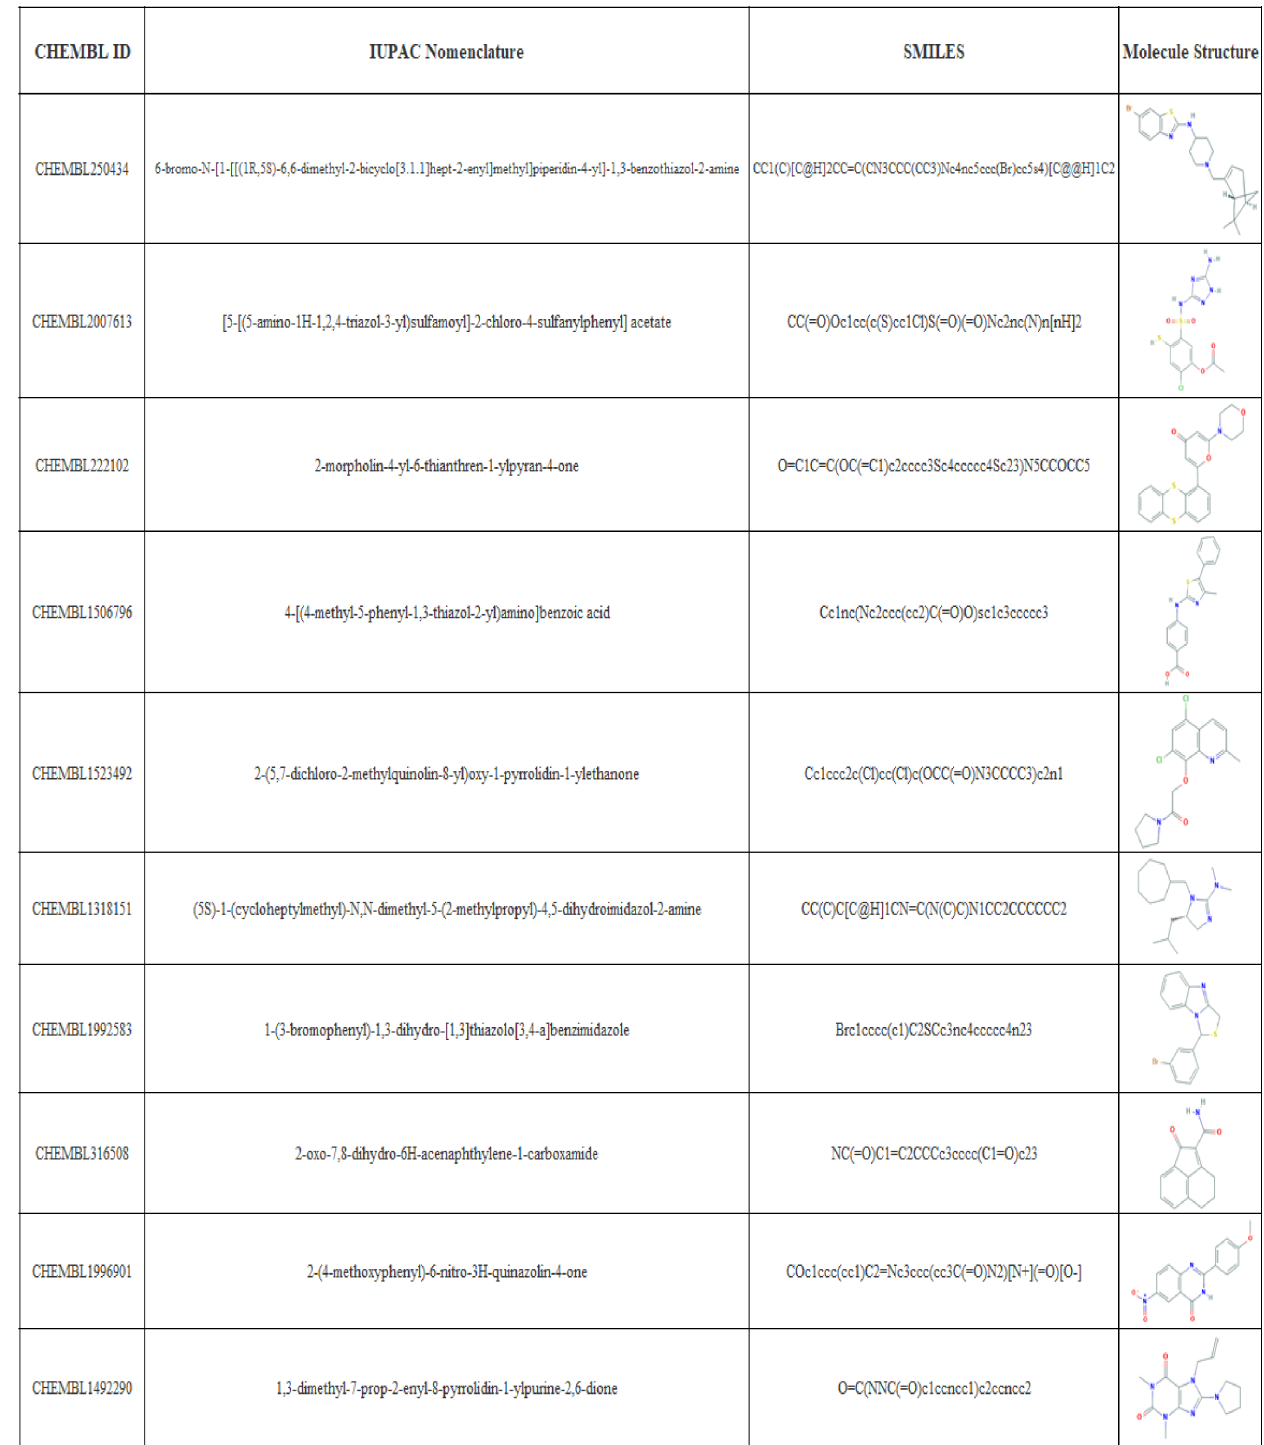
Fig 8. Top-10 predictions of PharmaNet towards FPPS on the CHEMBL subset data. CHEMBL ID, IUPAC name, SMILE and the molecule structure is given for the best 10 performing molecules in CHEMBL subset data towards FPPS target when predicting with PharmaNet.